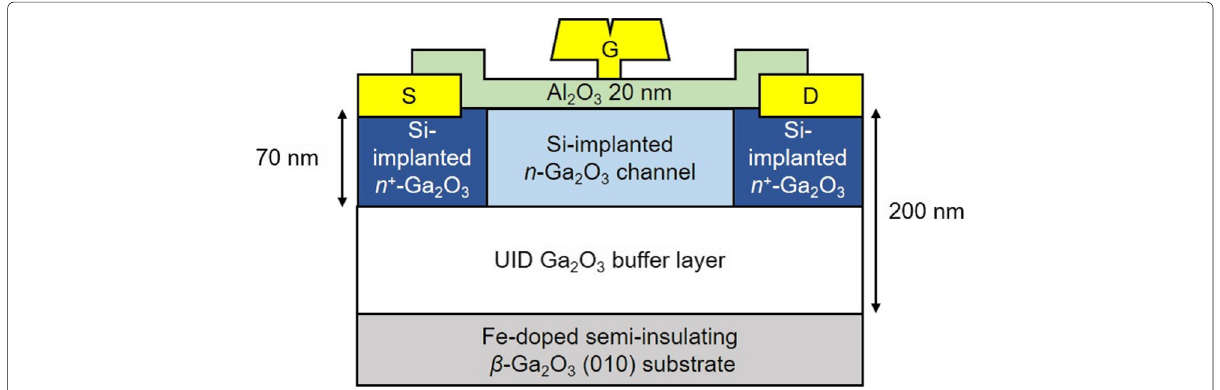
Fig. 13 Schematic cross section of short-gate Ga 2 O 3 MOSFET. Adapted with permission [94]. Copyright 2020,